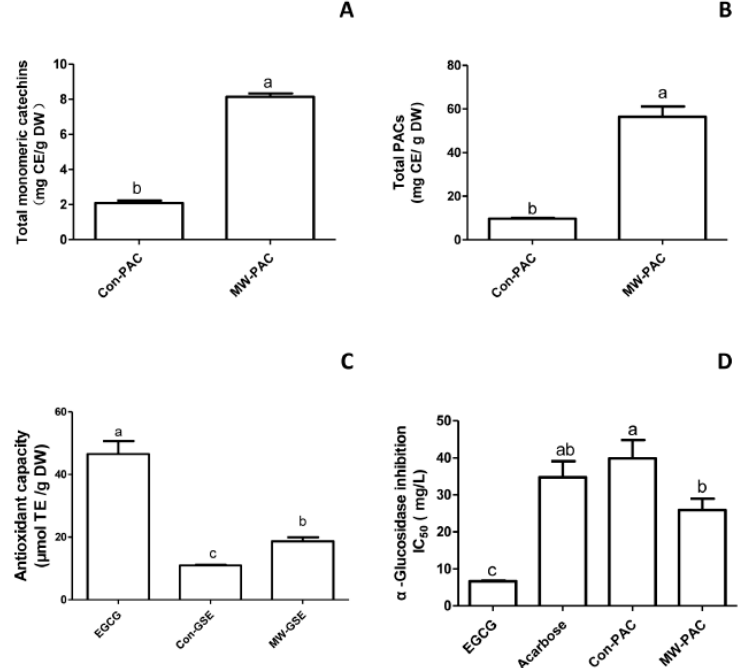
Figure 4. The total monomeric catechins ( A ), total PACs ( B ), total antioxidant capacity (FRAP method) ( C ), and inhibition of α -glucosidase ( D ) of Con-PAC and MW-PAC. The total PAC content is expressed in mg catechin equivalence (CE)/g DW of the sample. Epigallocatechin gallate (EGCG), and acarbose were used for the comparison purpose. Means sharing the same letter are not significantly different at the 5% level.